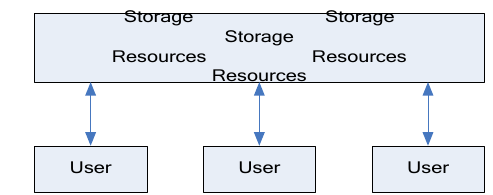
Figure 2. The cloud storage